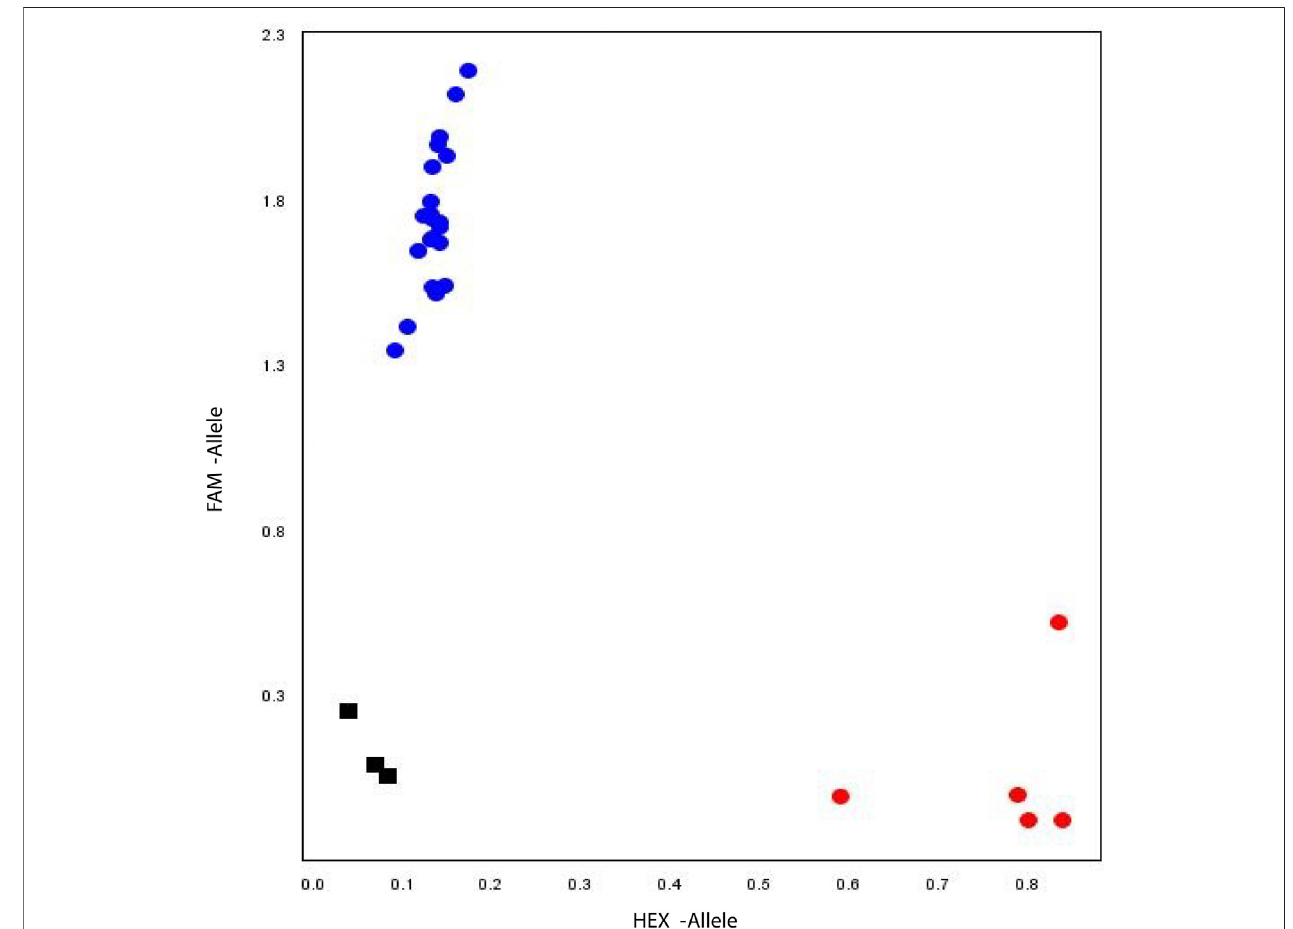
FIGURE 7 | Allelic discrimination plot. KASP assay of GmHH3-3 along X - and Y -axes. Blue dots represent accessions carrying the FAM type allele, and red dots show accessions having the HEX-type allele. Black box shows the non-template control.